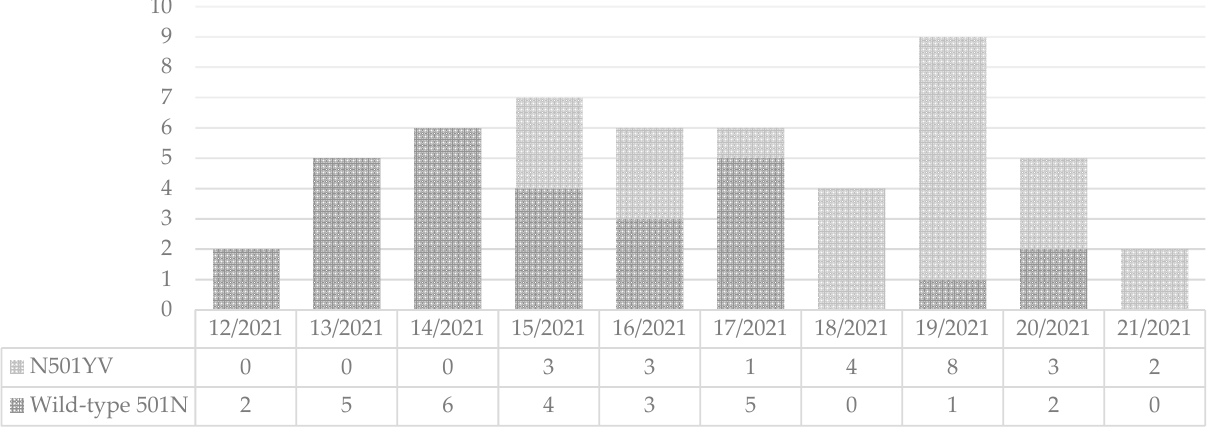
Figure 1. Changes in the number of N501YV infection diagnosis per week.